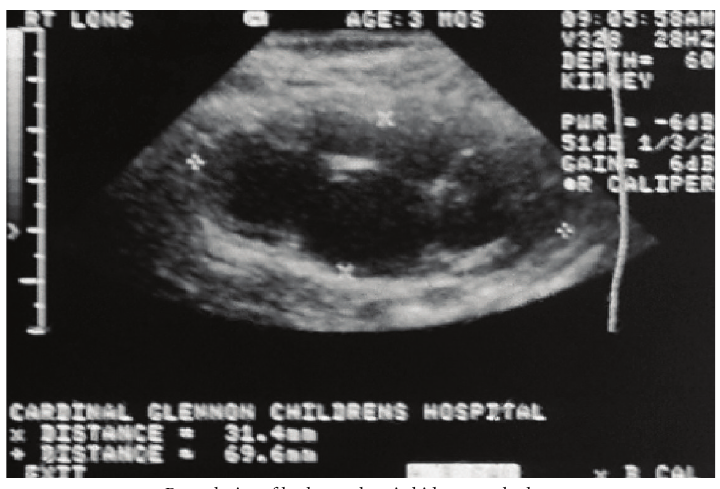
Figure 1: Boundaries of hydronephrotic kidney marked.